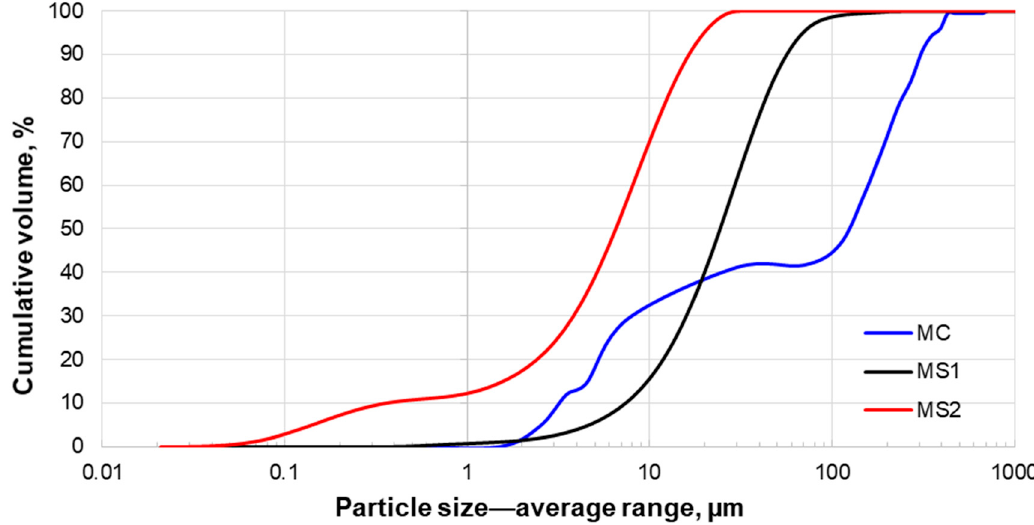
Figure 1. Cumulative particle size distribution curves for di ff erent methods of particle size measurement. In the case of MC, it considers nine original samples.